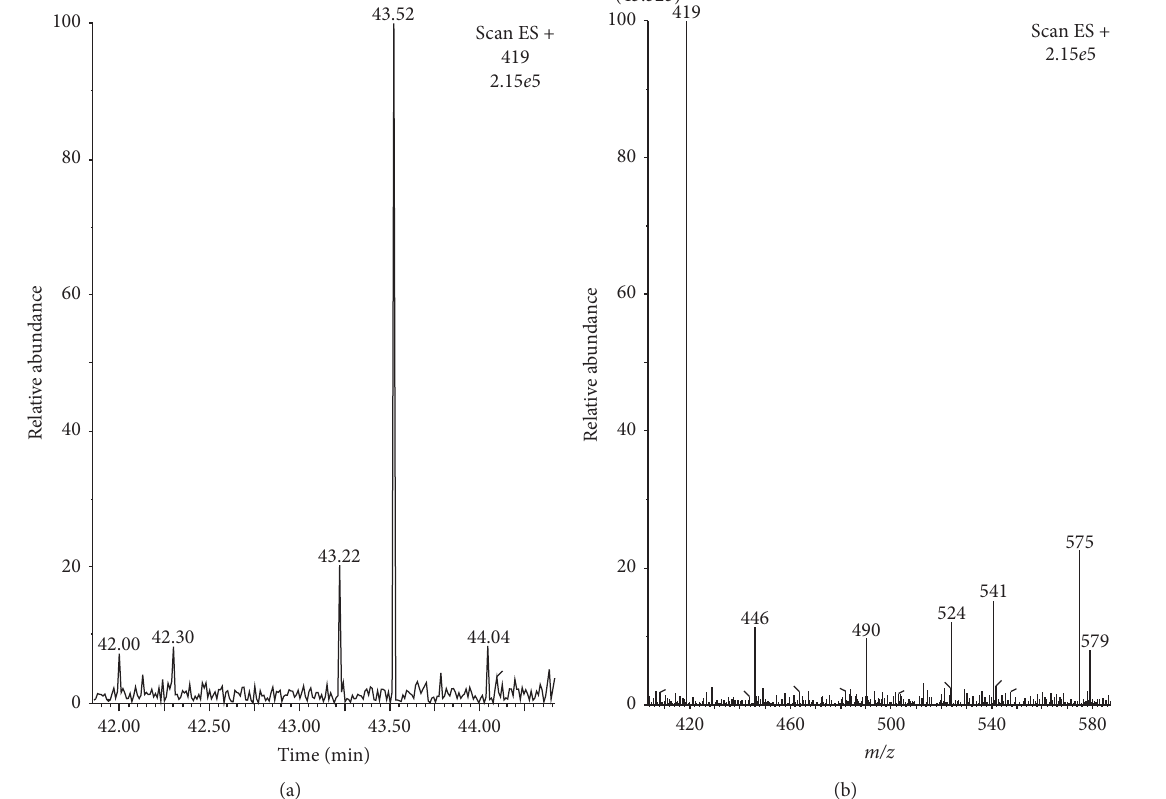
Figure 1: Extracted ion chromatogram (a) and the corresponding mass spectrum (b) based on the protonated molecular ion at m / z 419 that could arise from unreacted cholesterol hydroperoxide 4 or secosterol aldehydes 2 and 3